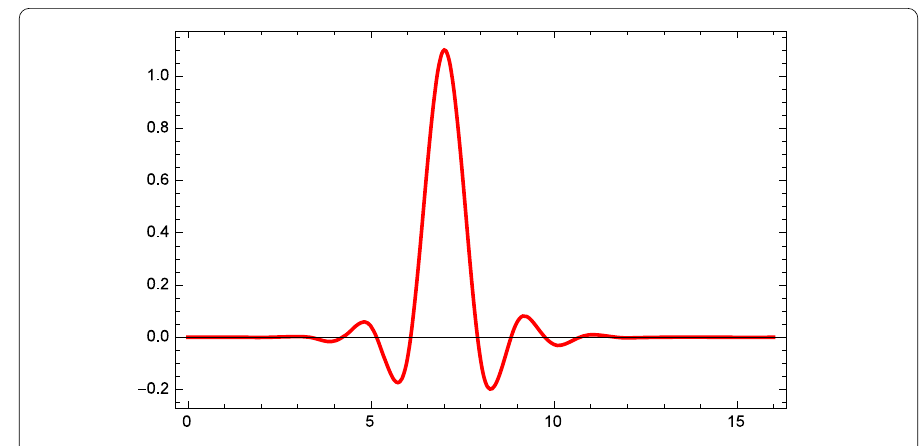
Figure 1 Generalized Coiflet scaling function for N = 6 and M 1 =